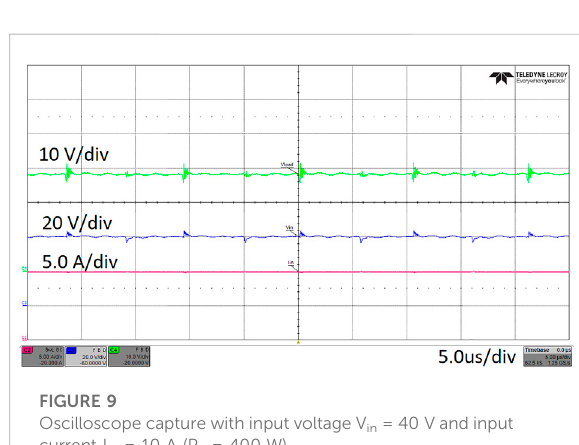
FIGURE 9 Oscilloscope capture with input voltage V in = 40 V and input current I in = 10 A (P d = 400